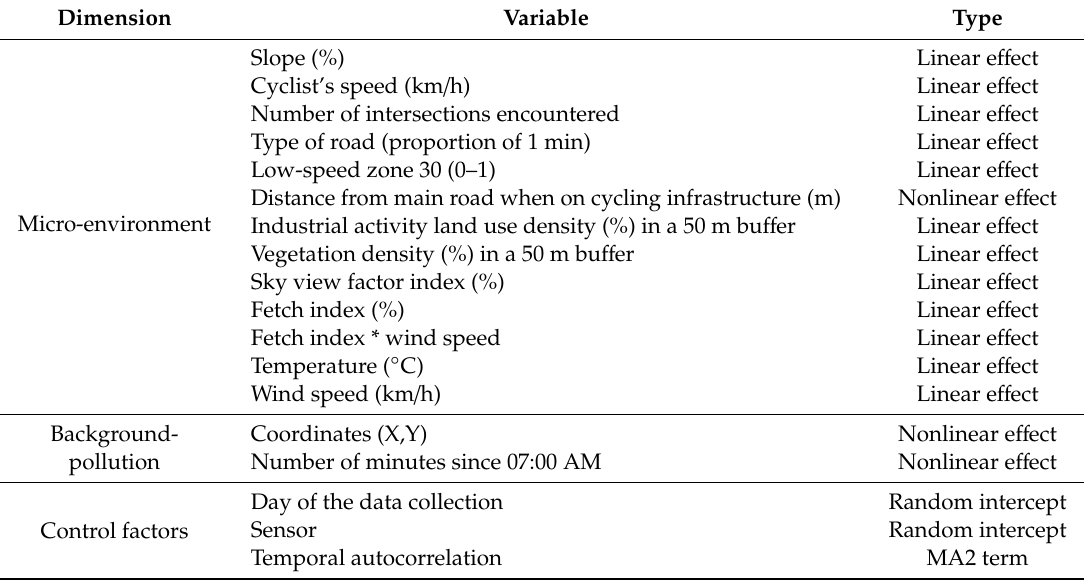
Table 1. Independent variables included in the regression